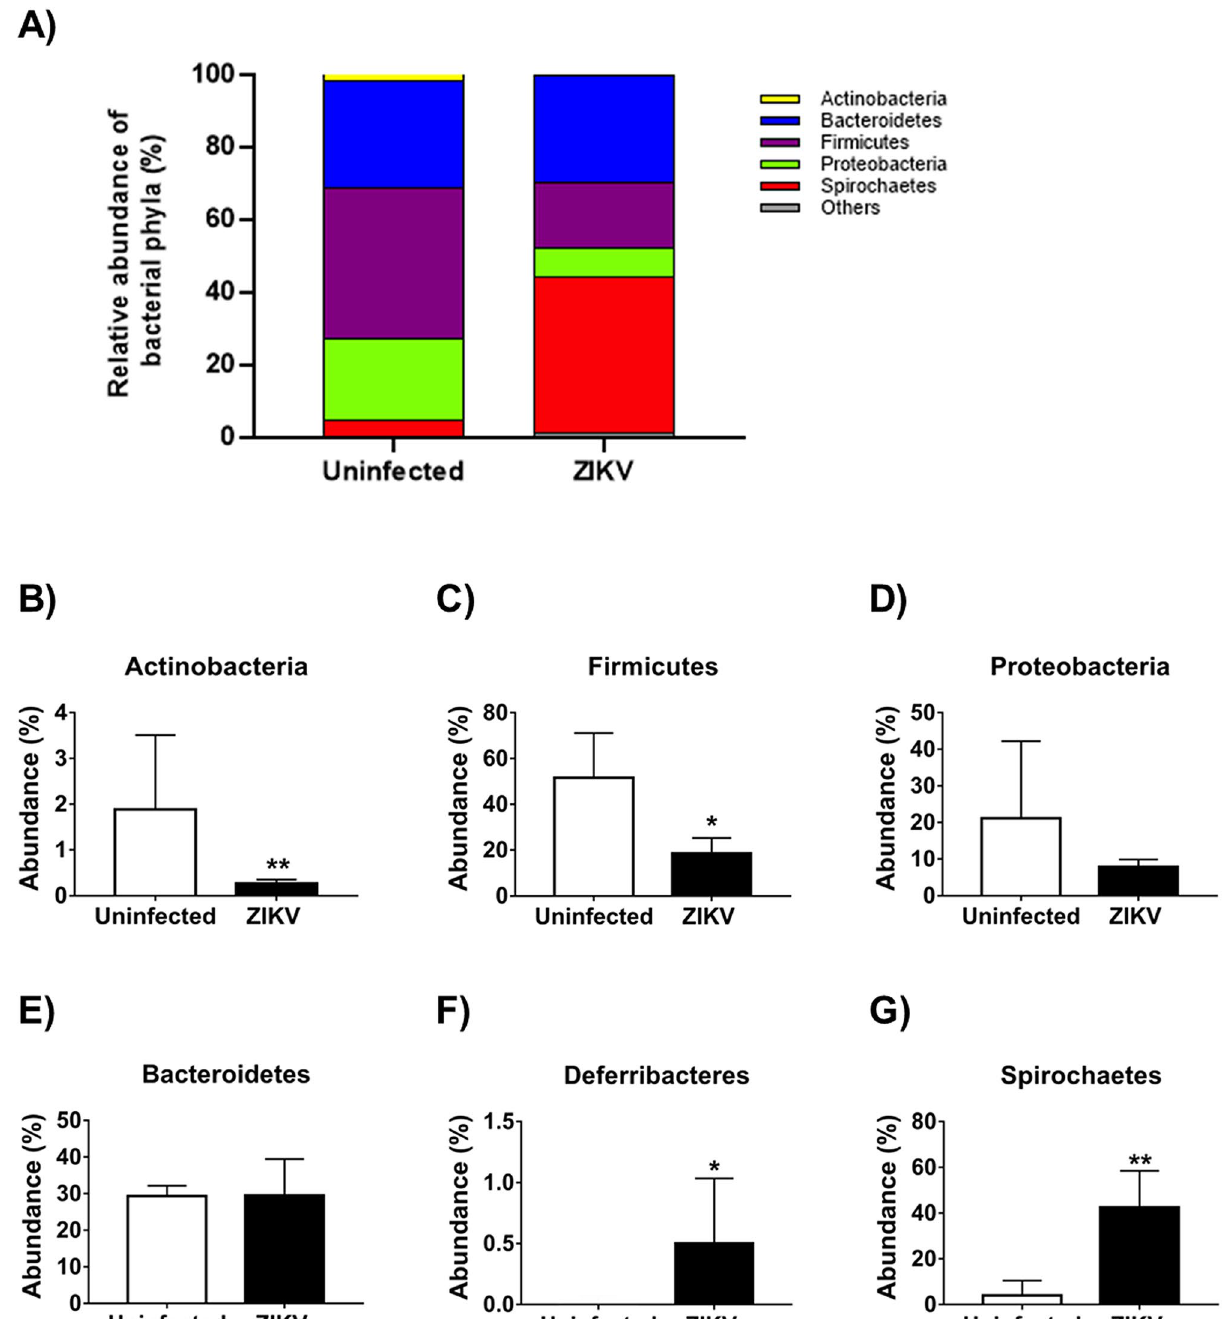
Figure 2. Phylum analysis of the gut microbiota modulation induced by ZIKV infection in the adult immunocompetent mice. C57BL/6J mice (N = 5) were infected with ZIKV and fecal samples were collected after 14 days post-infection. The gut microbiota diversity was assessed by 16S rDNA gene sequencing of the V4 region using the Illumina HiSeq platform. Bar charts represent the relative abundance of Phylum ( A ), Actinobacteria ( B ), Firmicutes ( C ), Proteobacteria ( D ), Bacteroidetes ( E ), Deferribacteres ( F ), and Spirochaetes ( G ). Statistical analyses were performed using a Student’s two-sample t-test, the non-parametric p-values were calculated with the Mann Whitney test, the bars represent a confidence interval of 95% (*p < 0.05; **p <